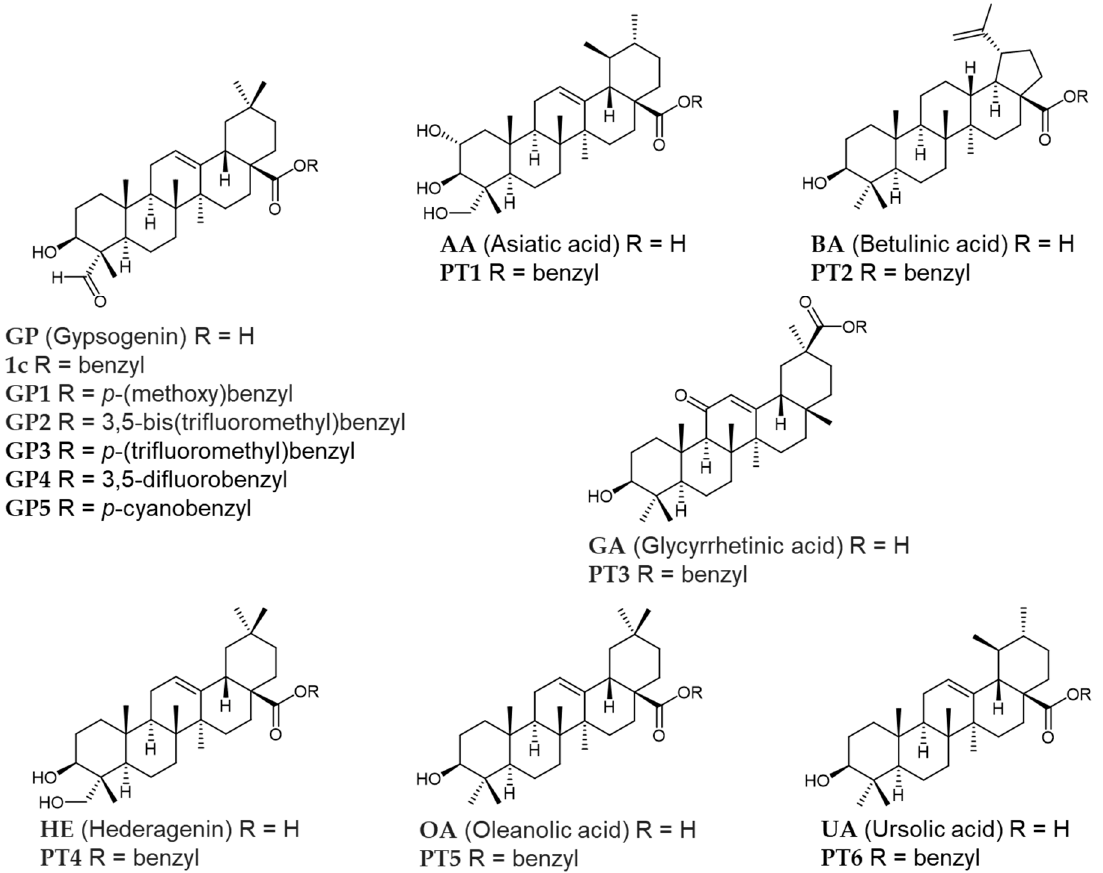
Figure 1. Structures of pentacyclic triterpenes and its derivatives used in this study.